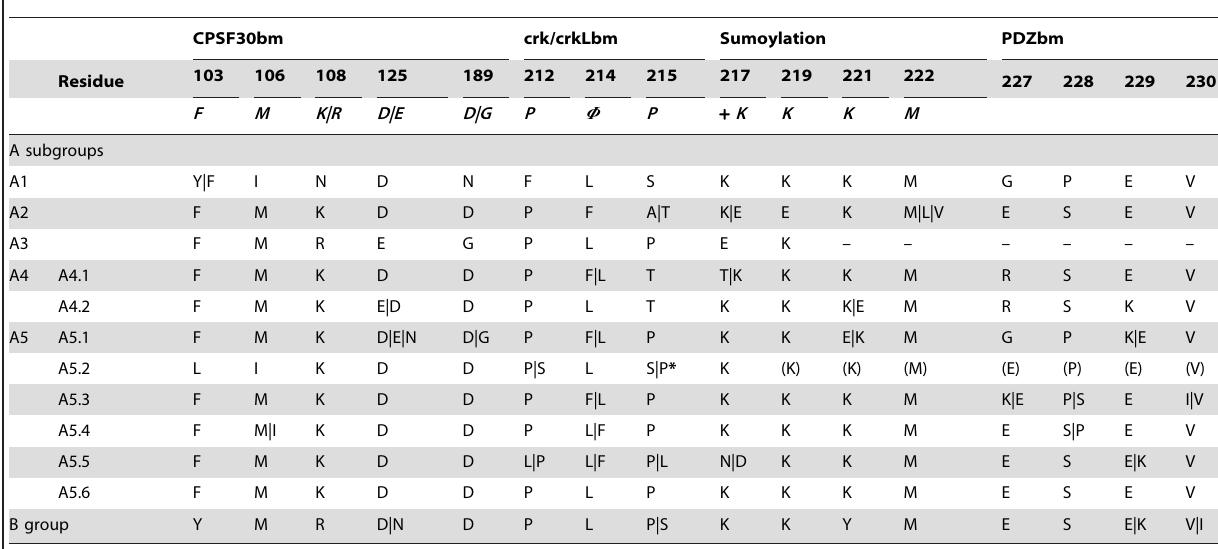
Table 5. High domain conservation in NS1 groups, subgroups and